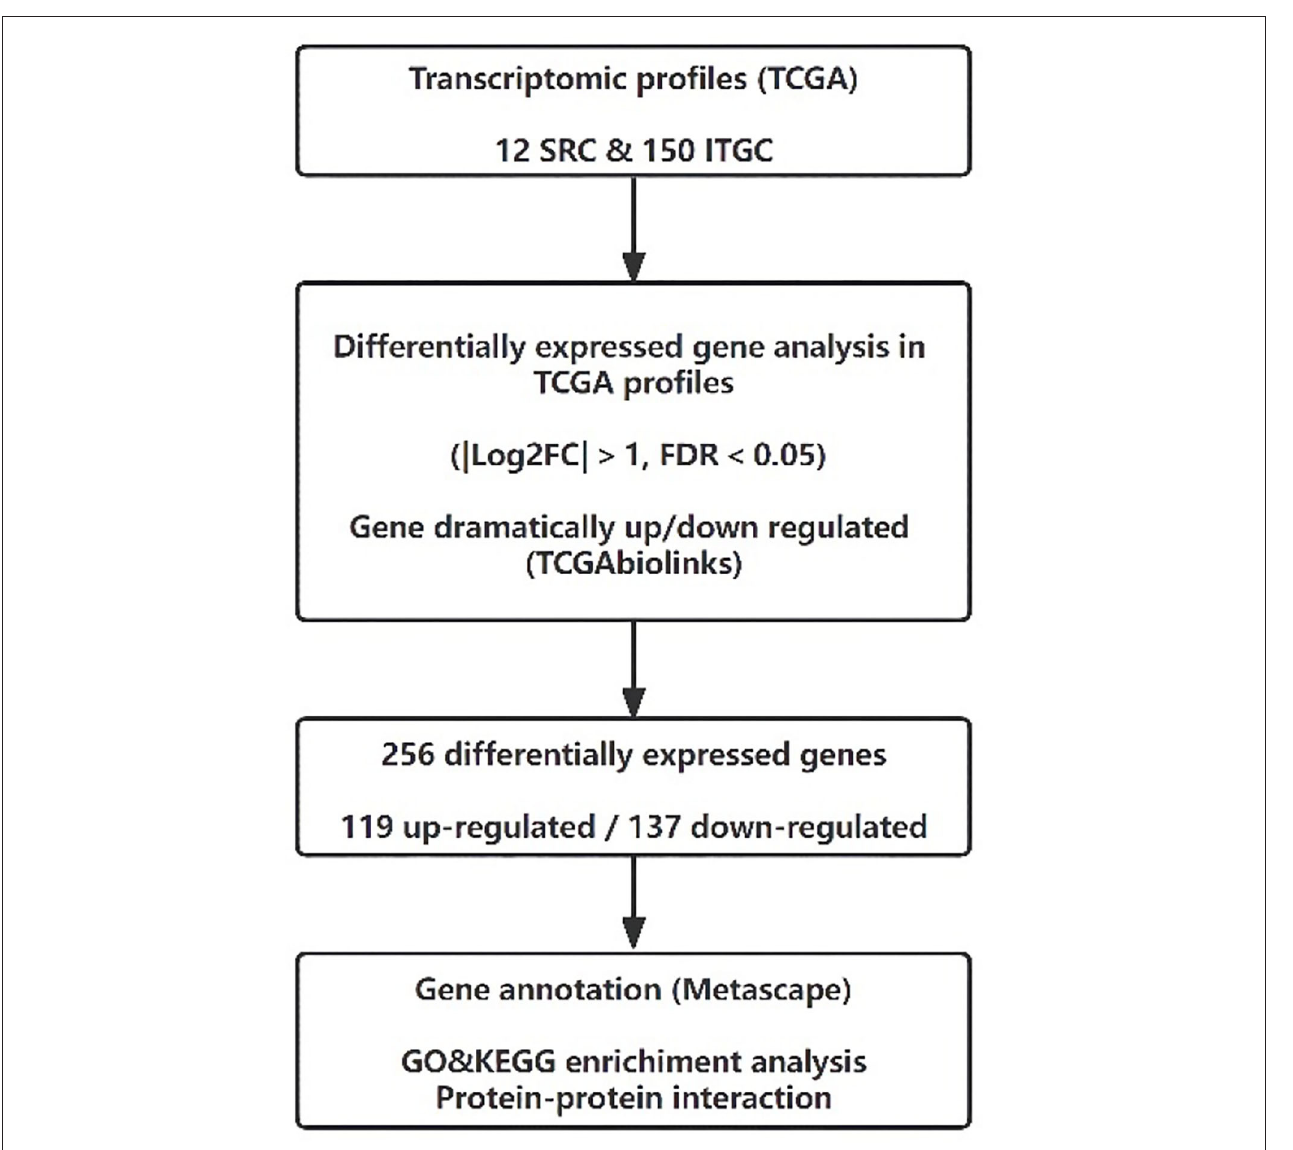
FIGURE 2 | Flow diagram of transcriptomic profiles in The Cancer Genome Atlas